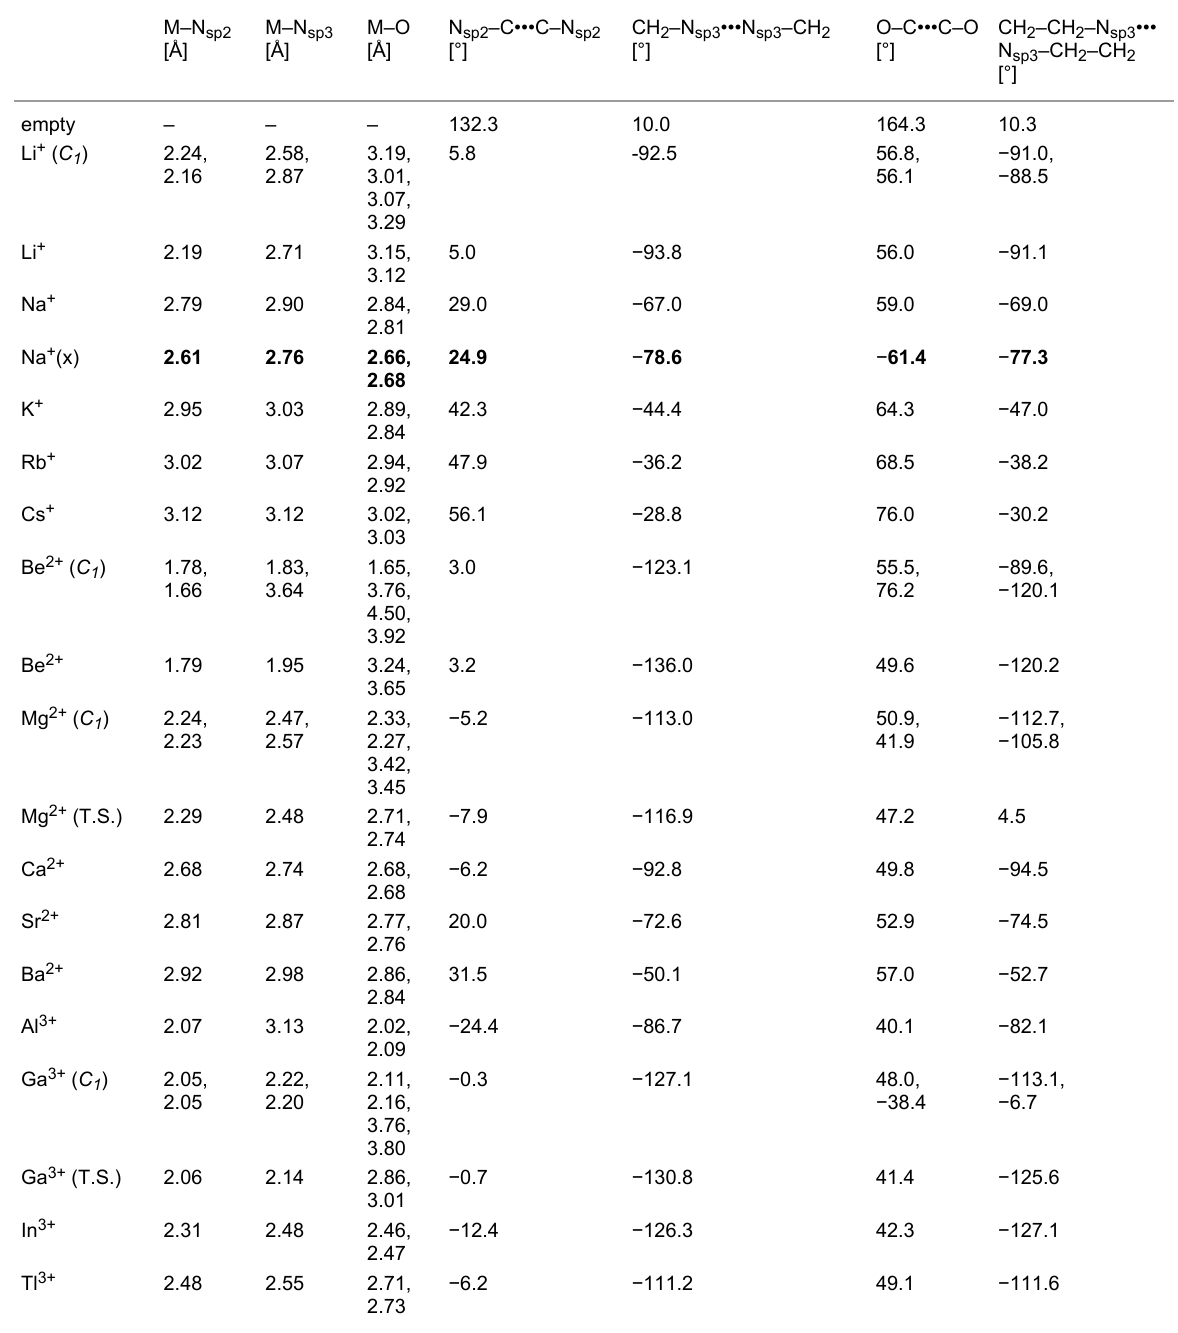
Table 1: Calculated (RB3LYP/LANL2DZp) structural data for the metal–donor interactions in [M 2.2.bpy] m+ (calculated structures: C 2 symmetry); (x): averaged experimental X-ray structural data